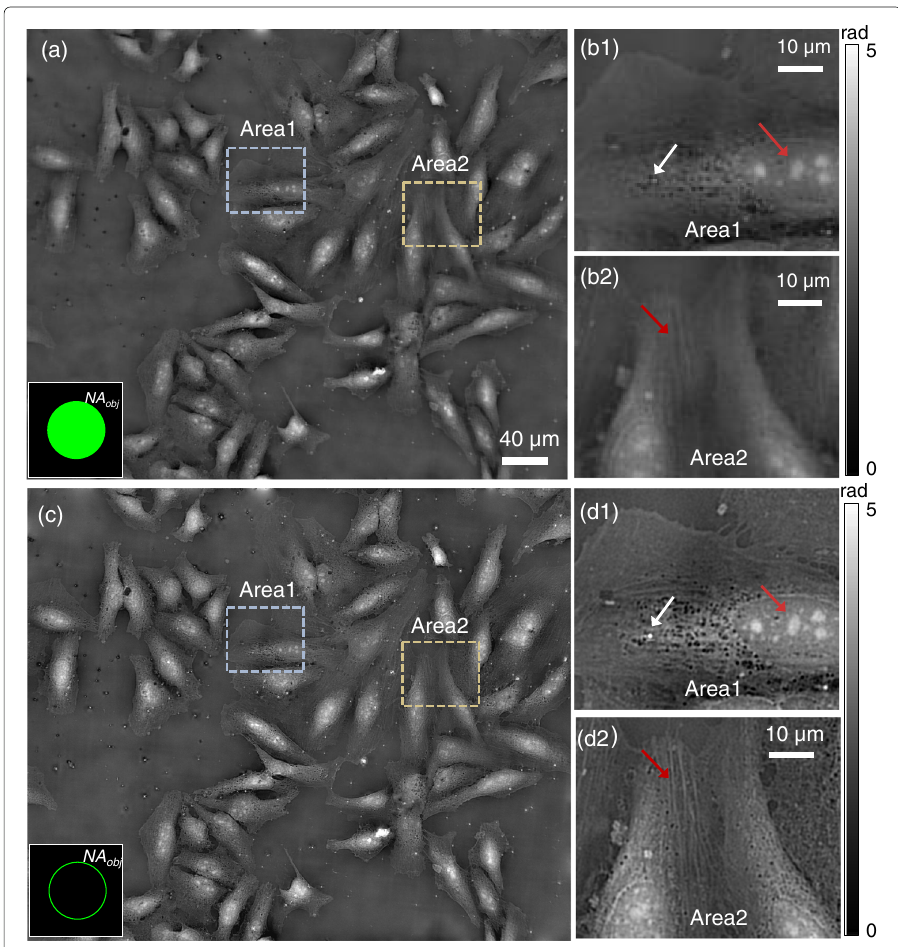
Fig.17 ThecomparisonofreconstructedquantitativephaseofHeLacellundercircleandannularillumination apertures. (a) The reconstructed phase of HeLa cells under circle illumination aperture. (b1)-(b2) The enlarged images of the sub-region of Area1 and Area2 in (a). (c) The reconstructed quantitative phase of HeLa cells under annular illumination aperture. (d1)-(d2) The enlarged images of the subregion of Area1 and Area2 in (c)